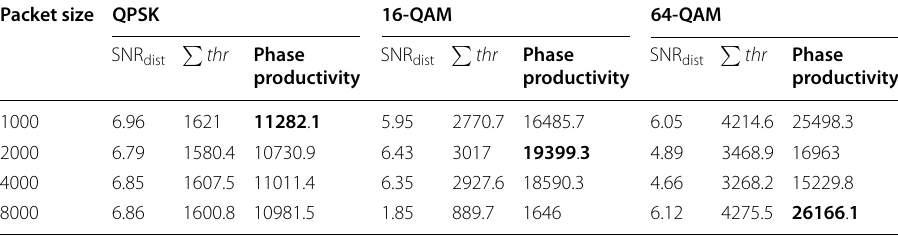
Table 9 Phase productivity for different packet sizes and modulations in the existing system Packet size QPSK